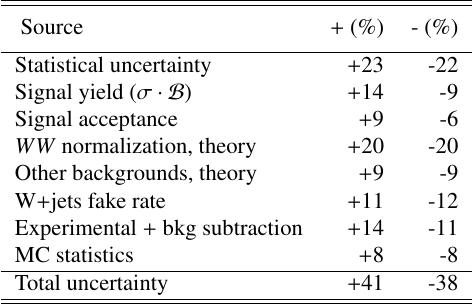
Table 1. Dominant contributions to the relative uncertainty on the measured signal strength for m H = 125 GeV [5]. The total relative uncertainty is also